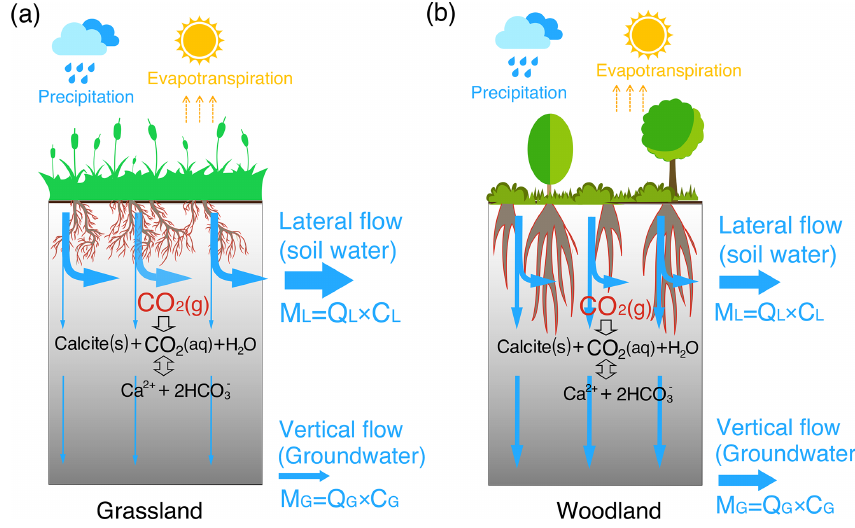
Figure 1. A conceptual diagram of hydro-biogeochemical interactions in the grassland (a) and woodland (b) . The shallow and dense fine roots in the grassland promote lateral macropore development and lateral water flow. In contrast, the woodlands induce vertical macropore development that supports vertical flow (recharge) into the deep, calcite-abundant subsurface compared to the grassland. The gray color gradient reflects the calcite abundance with more calcite in depth. M L and M G with a unit of moles per year ( = flow rate Q (m/a) × species concentration C (mol/m 3 ) × cross-section area (m 2 ) ) represent mass fluxes from lateral flow (soil water) and from vertical flow into ground- water, respectively. Soil water and groundwater were assumed to eventually flow into stream, adding up to the total discharge (infiltration) rate Q T = Q L + Q G